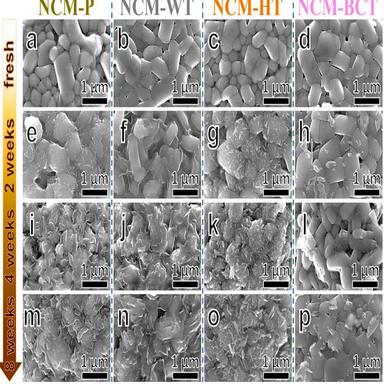
SEM images of NCM-P, NCM-WT, NCM-HT, and NCM-BCT samples: (a-d) fresh state; (e-h) store in ambient air for 2 weeks; (i-l) store in ambient air for 4 weeks; (m-p) store in ambient air for 8 weeks.